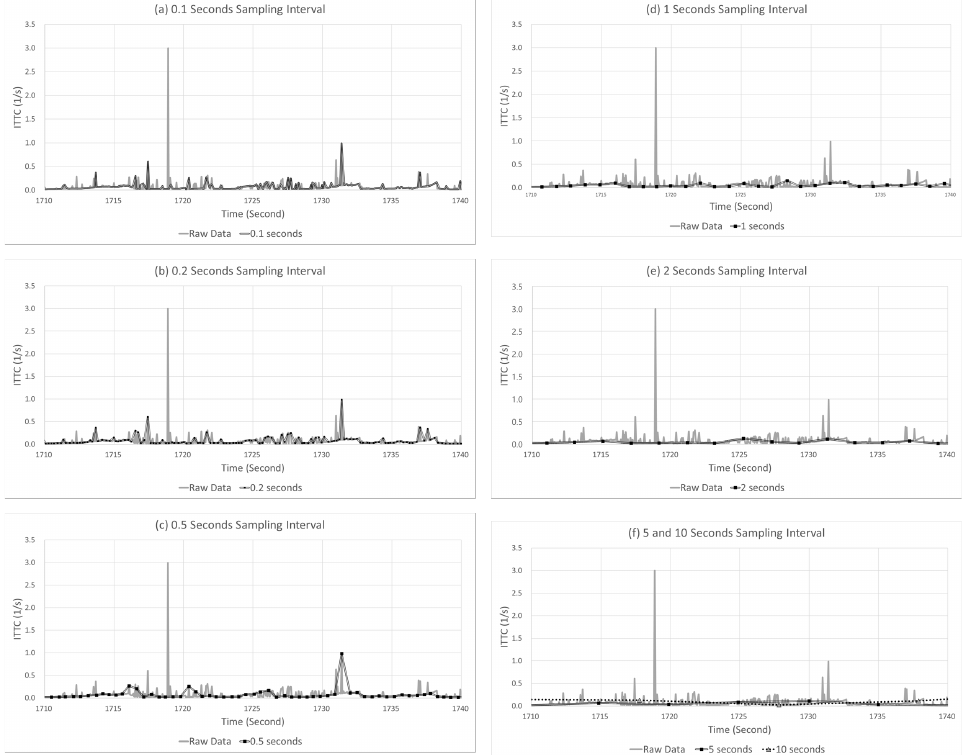
Figure 14. Example case of the ITTC varying the sampling intervals.